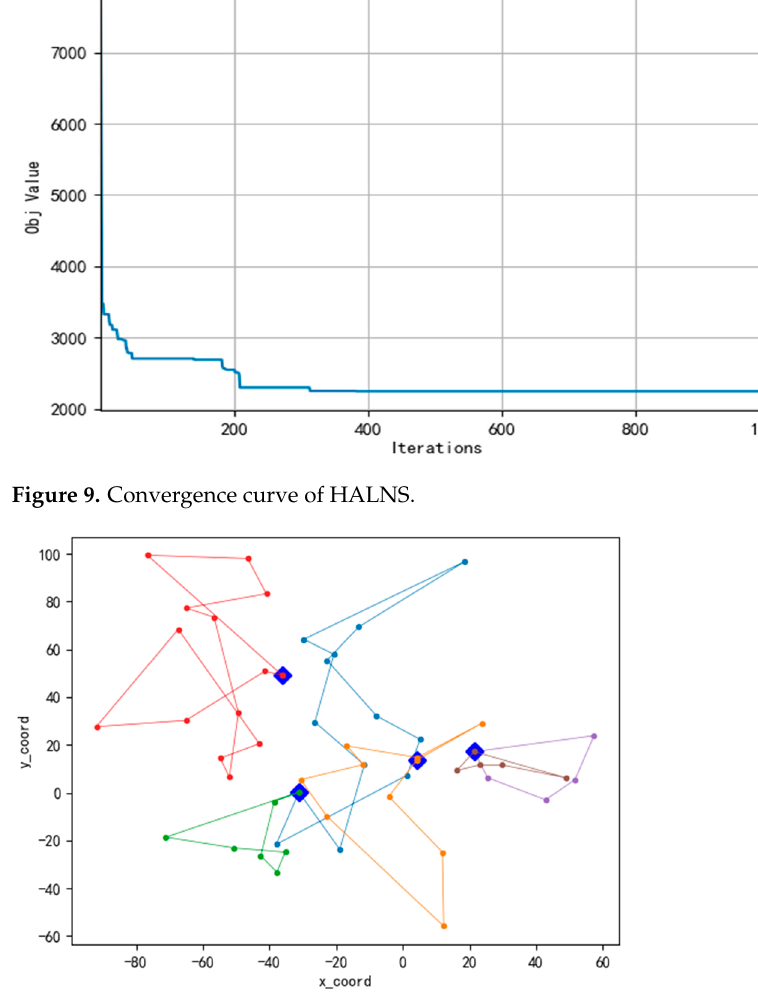
Figure 10. Optimal route of pr01 benchmark.